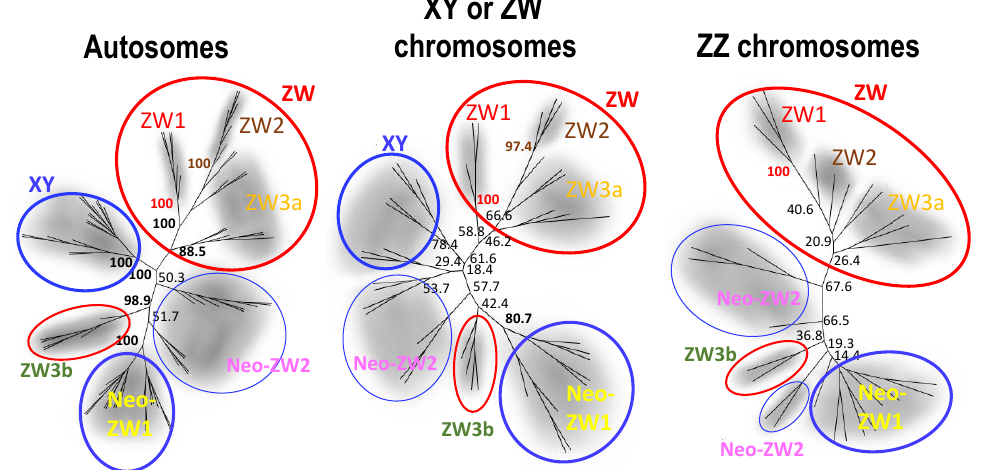
Figure 3. Neighbour-joining trees based on SNPs of autosomes, XY or ZW chromosomes, and ZZ chromosomes. Bootstrap probabilities are put on the major nodes. The coloured outlines of circles indicate two major mitochondrial haplogroups of ZW group (red) and XY group (blue). Abbreviations are the same as those of Figure 2.